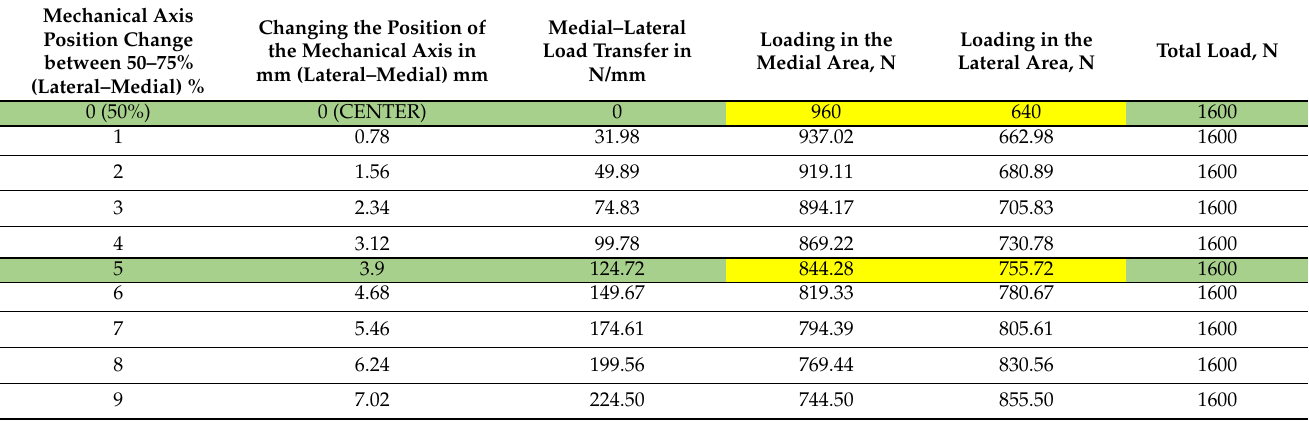
Table 2. The load values depending on the change in the position of the mechanical